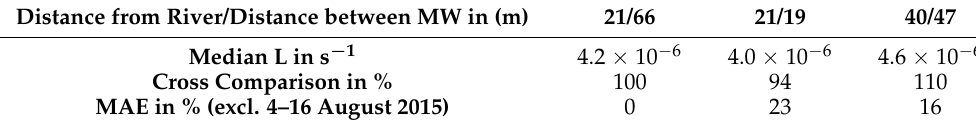
Table 3. Effect of monitoring well- separation distance at transect II (Fragment